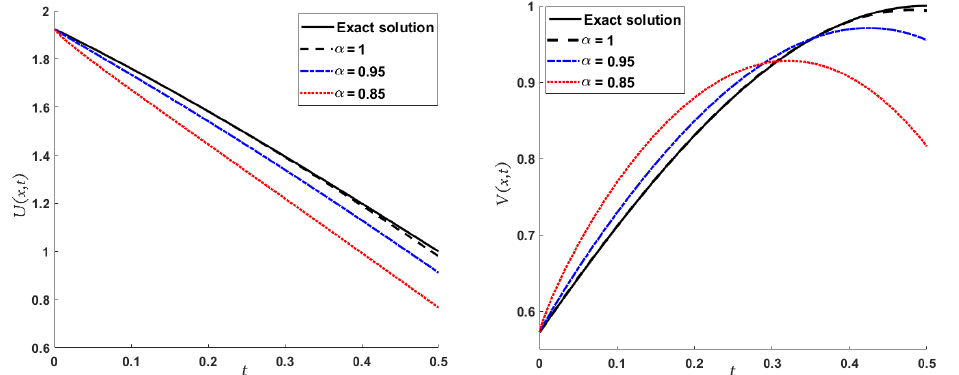
Figure 3. Two-dimensional plots of the approximate and exact solutions of U ( x , t ) , V ( x , t ) (Example 1) using the LADM, when x =